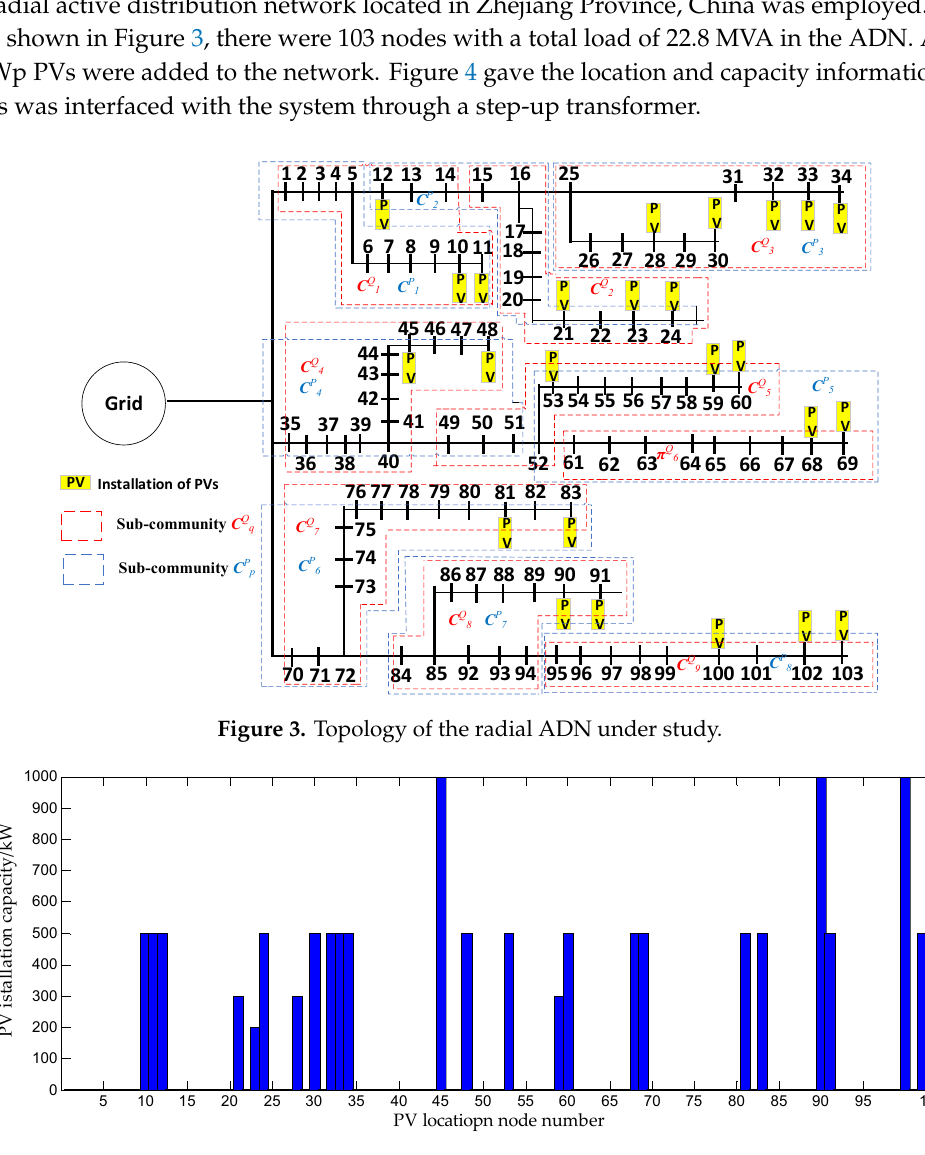
Figure 4. The location and capacity information of PVs in the ADN.